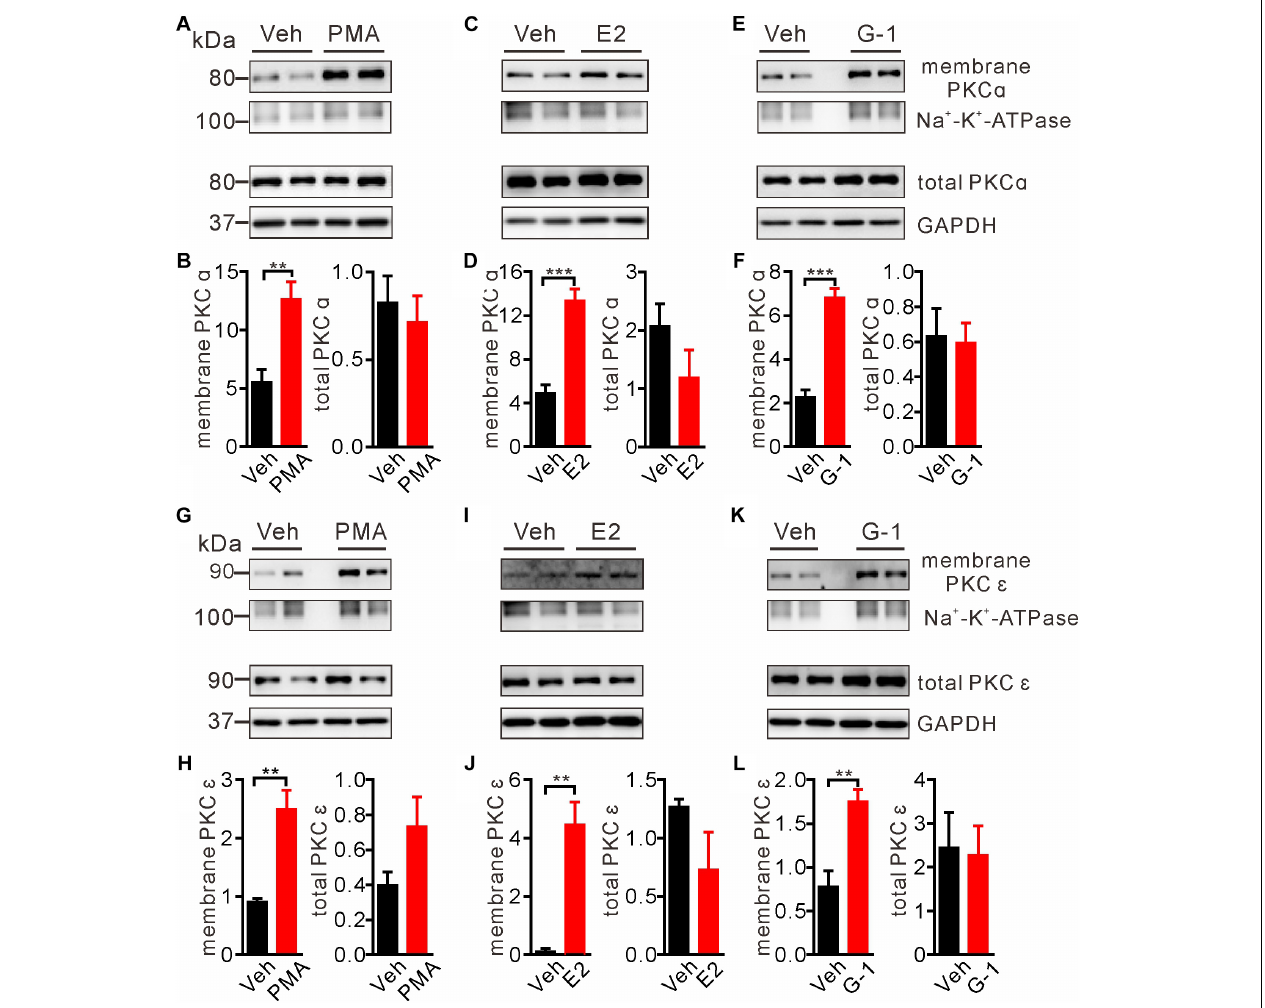
FIGURE 4 | E2 and G-1 promoted translocation of PKC isoforms to the plasma membrane. (A,B,G,H) Cells treated with the pan-PKC agonist PMA (1 µ M) for 5 min had significantly higher PKC α and PKC ε in the plasma membrane protein samples, compared with vehicle-treated cells. (C,D,I,J) Cells treated with E2 (1 µ M) for 5 min had increased PKC α and PKC ε in the plasma membrane protein samples as compared with cells treated with vehicle. (E,F,K,L) Cells treated with G-1 (1 µ M) for 5 min had increased PKC α and PKC ε in the plasma membrane protein samples as compared with cells treated with vehicle. After detected PKC α bands (C,E) , the nitrocellulose membrane was stripped and re-blocked by 5% fat-free dry milk in TBST, followed by incubation with PKC ε primary antibody, then PKC ε bands was detected (I,K) . So the loading controls are the same. Membrane PKC α or PKC ε is a relative value with Na + -K + -ATPase as the internal reference for plasma membrane protein; total PKC α or PKC ε is the relative value with GAPDH as the internal reference for total protein. ∗∗ P < 0.01, ∗∗∗ P < 0.001, unpaired t -test, averaged data from three to four independent